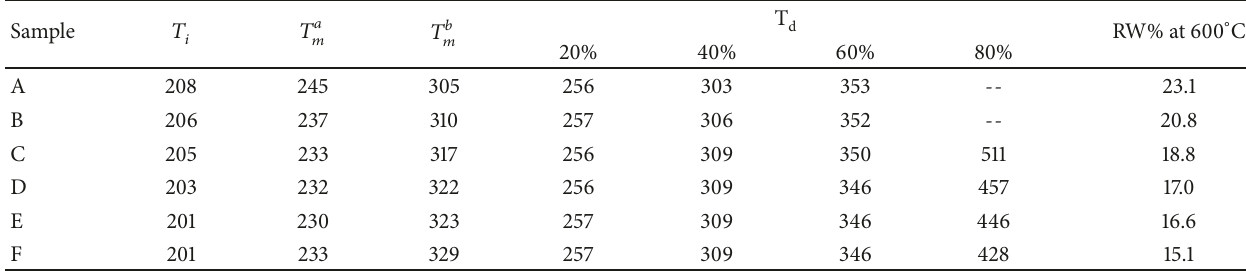
Table 3: Thermal analysis of unmodified and EGDE-modified SF